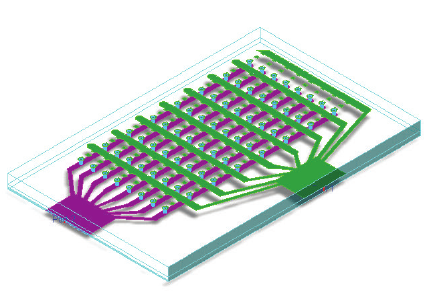
Figure 9: 3D view of the proposed load switching array produced in ADS design